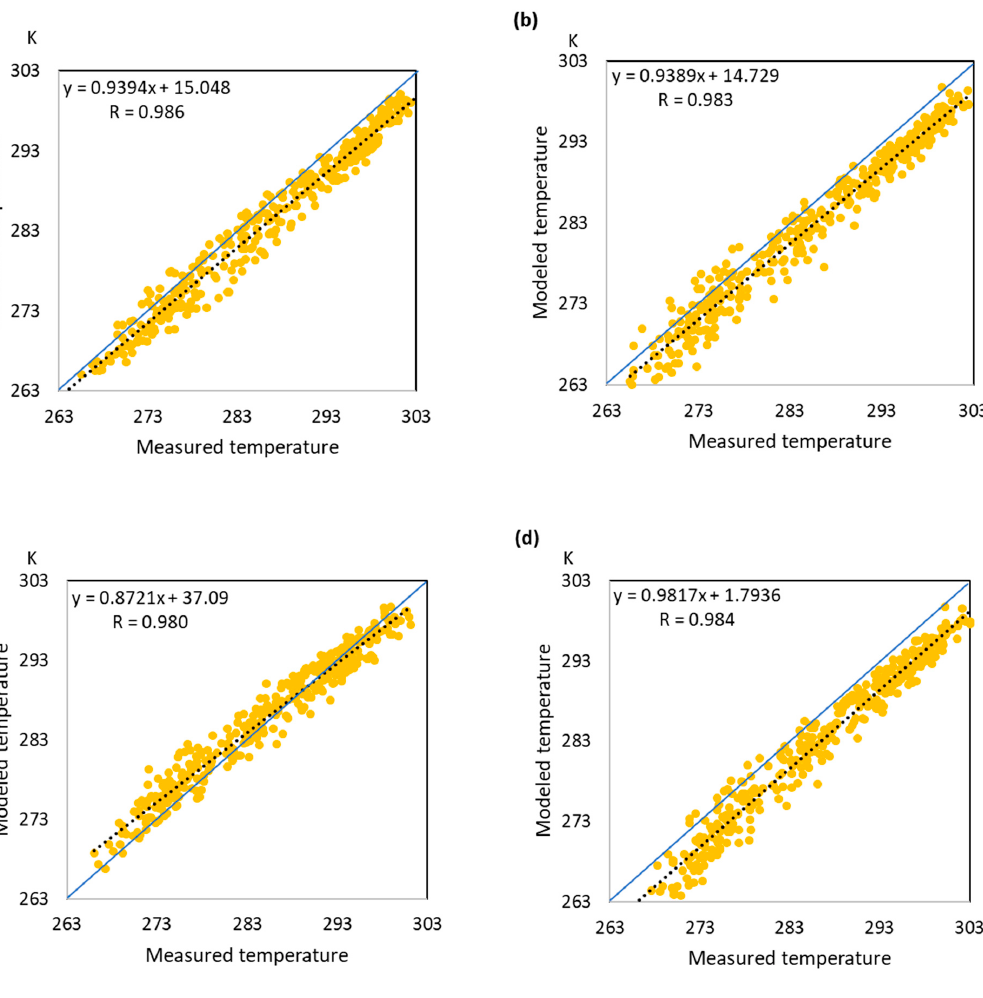
Figure 5. Correlation between Weather Research and Forecasting (WRF) model outputs and weather station measurements for temperature, at: ( a ) Seoul; ( b ) Chuncheon; ( c ) Chupungnyeong; and ( d ) Wonju.